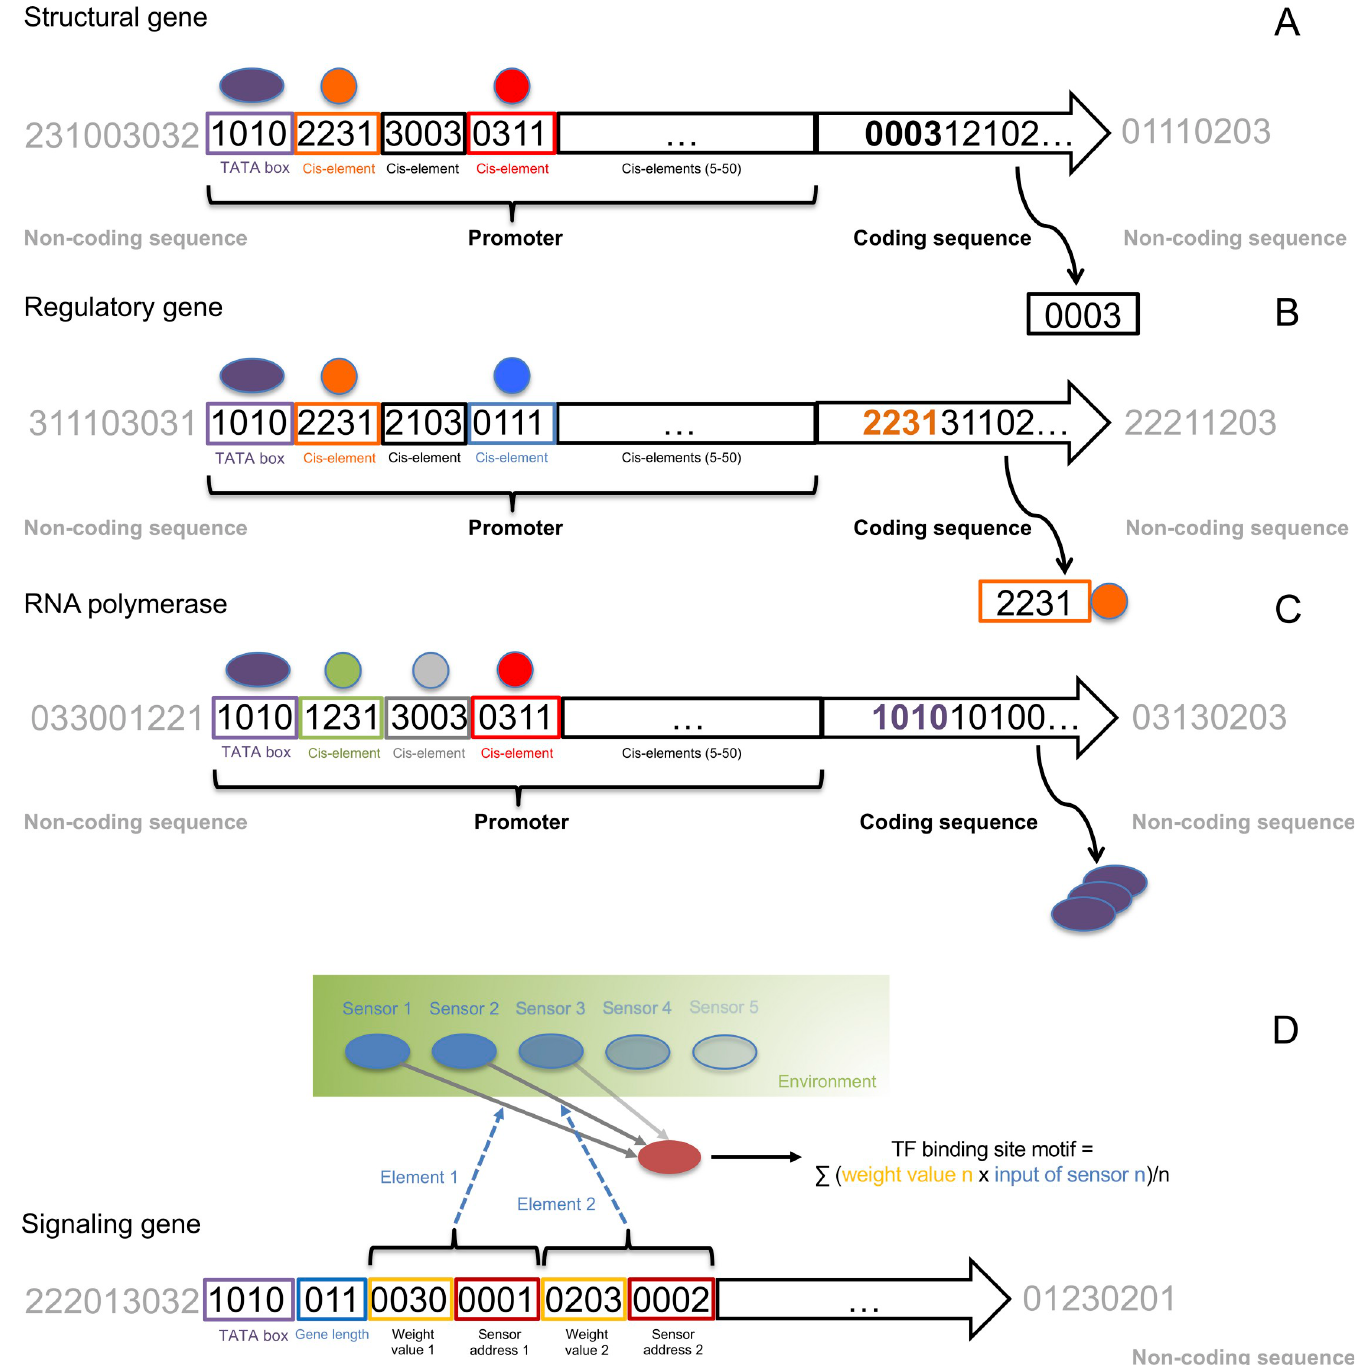
Fig 2. Every gene is defined by a promoter and a coding region. The promoter must start with a TATA box and be followed by a set of four-digit cis-elements numbering 5–50, each of which is bound by a specific kind of TF. The promoter region is followed by the coding region, whose first four digits define the specific kind of gene to be encoded. No interspersed sequence is allowed between any of the components of the gene. (A) Structural gene, which defines a specific kind of actuator. (B) Regulatory gene, which encodes a specific kind of TF defined by its cis-binding element (i.e., 2231). (C) RNA polymerase gene, which specifically binds to a TATA box (i.e., 1010). (D) Structure of a signaling gene, defining signaling pathways, which are defined as linear equations of sensor inputs. At each time step during the simulation, the value of each kind of sensor input (see Fig 1) is estimated and used as a variable in the equation. When the result of the equation corresponds to the identity number of a particular gene, its expression is activated. Linear equations are encoded in the sequence of the genome as shown. A special part of the gene sequence is specified for representing the equation and is composed of a group of ‘elements’, with each element having a fixed eight bases slot. The first four bases hold